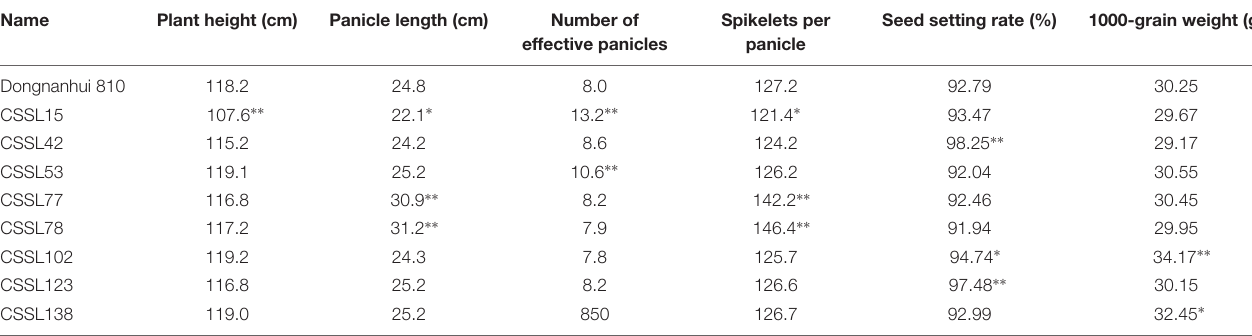
TABLE 6 | Comparison of main agronomic traits among eight CSSLs and Dongnanhui 810. Name Plant height (cm) Panicle length (cm) Number of